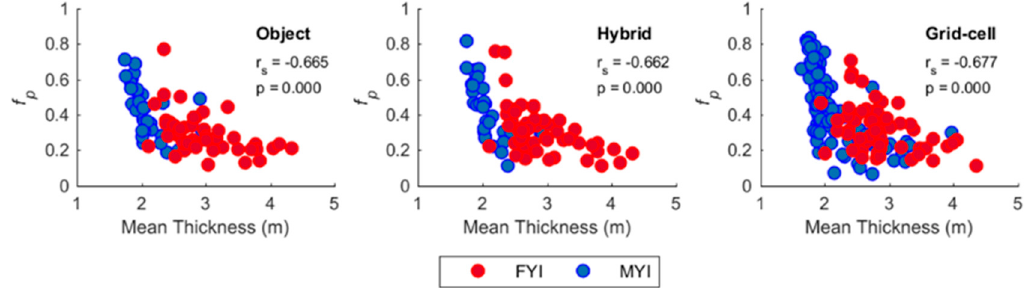
Figure 7. Scatter plots of f p as a function of mean thickness at the medium scale using object ( left ), hybrid object ( middle ) and 240 m grid-cell ( right ) aggregation approaches. Spearman correlation coefficients (r s ) and corresponding p -values are shown for pooled FYI and MYI data.